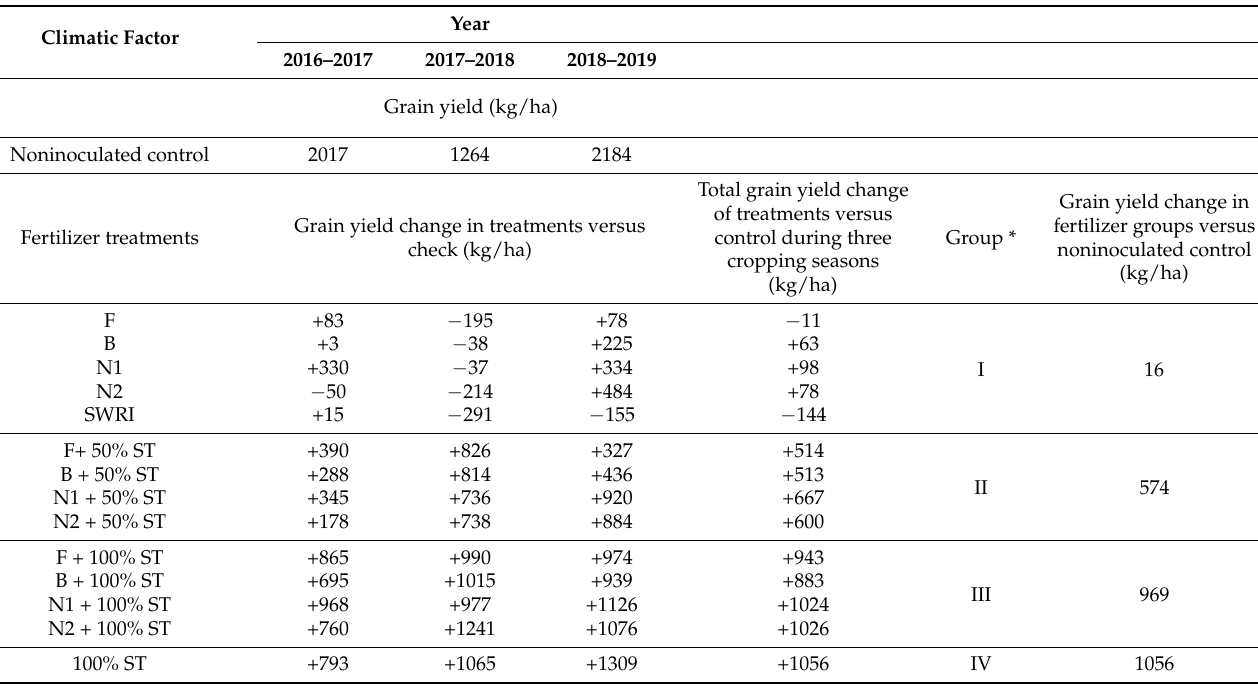
of PGPR biofertilizers. II: Application of PGPR + 50% of soil test need-based N, P, and Zn chemical fertilizers. III: Application of PGPR + 100% of soil test need-based N, P, and Zn chemical fertilizers. IV: Application of 100% soil